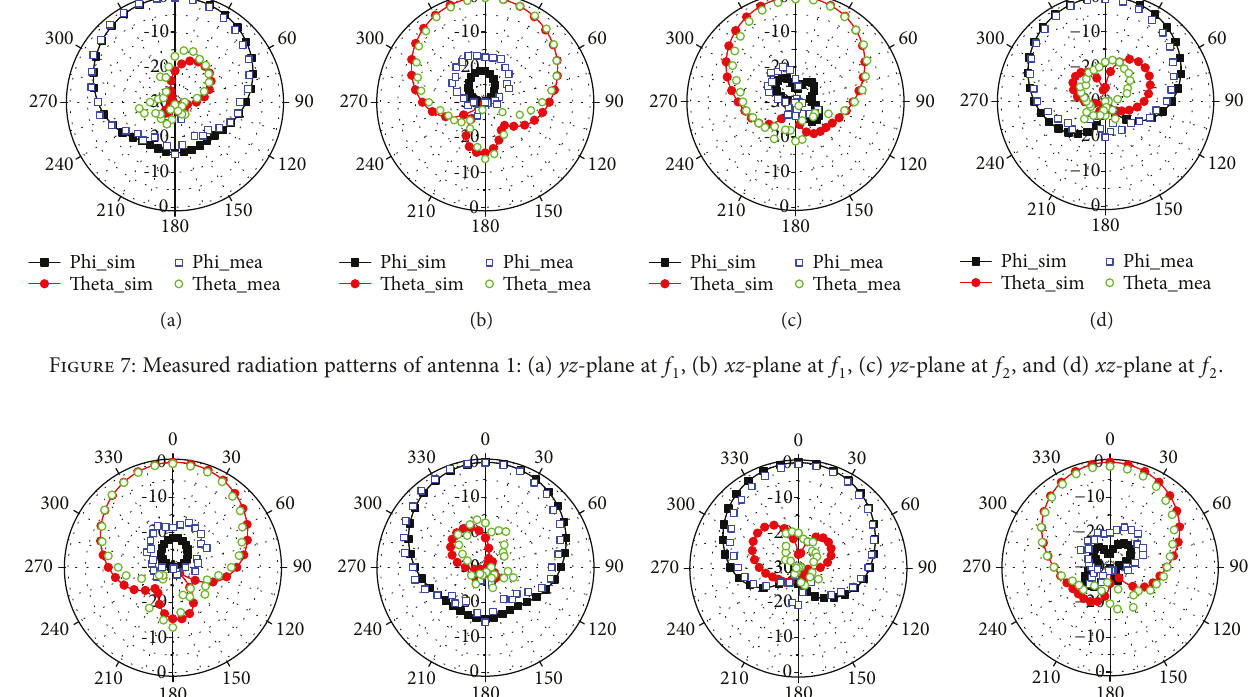
1 , (b) xz -plane at f 1 , (c) yz -plane at f 2 , and (d) xz -plane at f 2